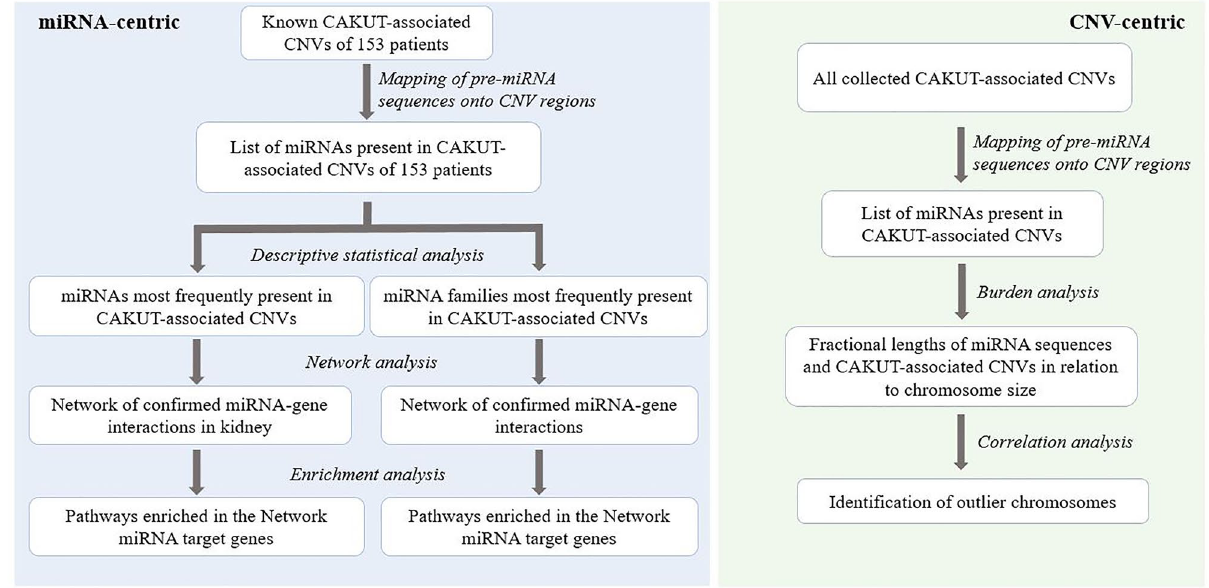
Figure 1. Study design. The miRNA-centric approach was based on data from 153 patients with identified CAKUT-associated CNVs 4 to functionally interpret the most frequently affected miRNAs. The CNV-centric approach aimed to estimate the overall burden of CAKUT-associated CNVs on miRNA genes, by including all major studies investigating CNVs in CAKUT 4,10–14